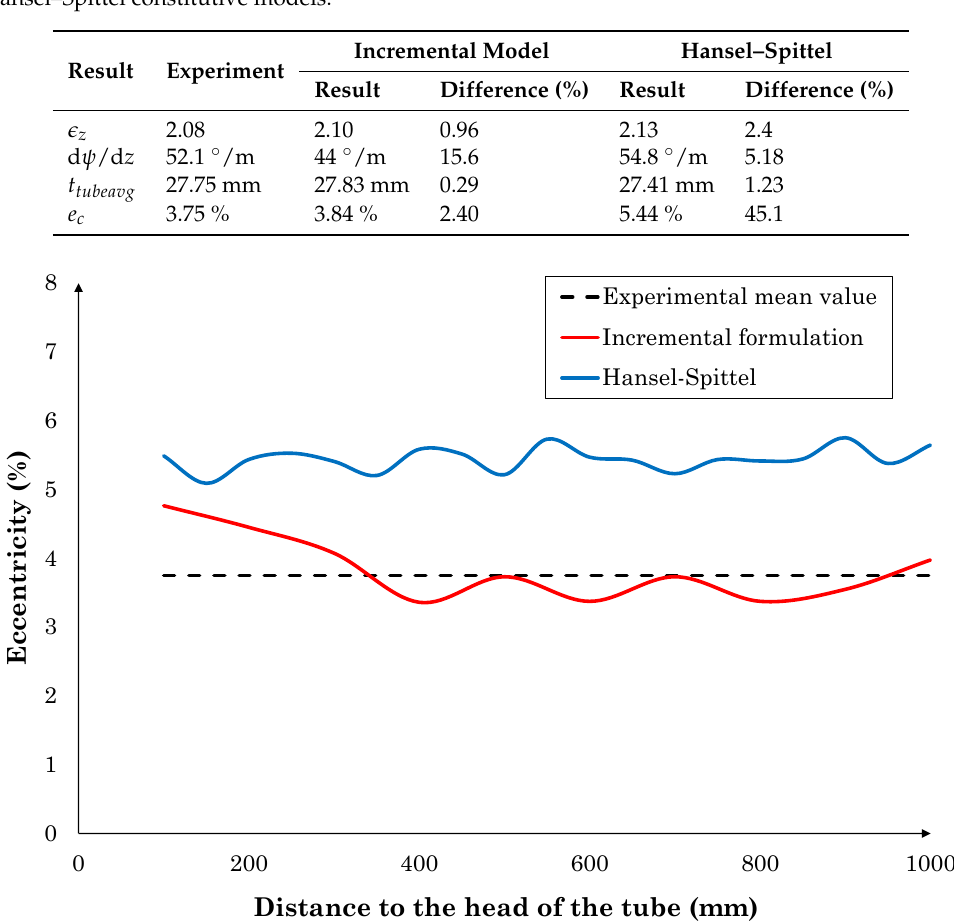
Table 3. Comparison of deformation numerical and experimental results using the incremental and Hansel–Spittel constitutive models.